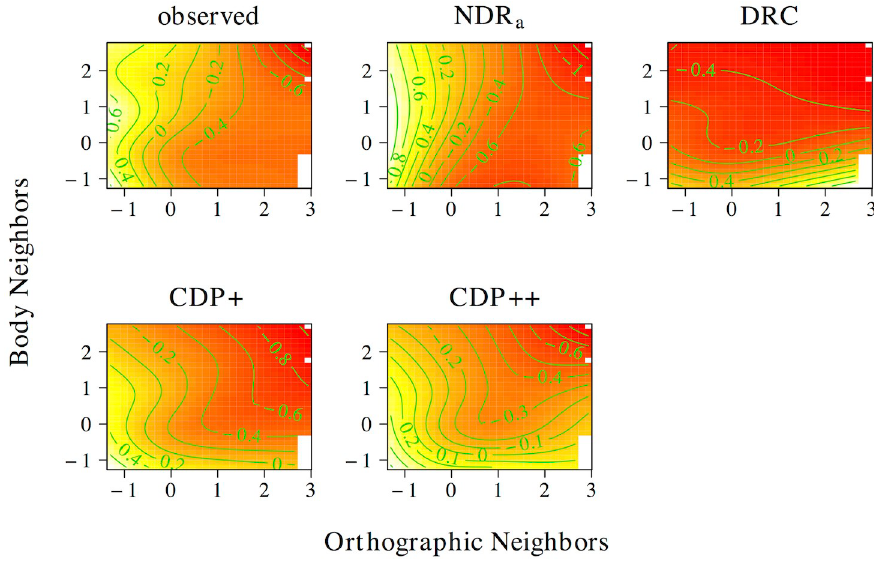
Fig 10. Interplay of orthographic and body neighborhood density. The non-linear interplay of orthographic neighborhood density and body neighborhood density in tensor product GAMs.